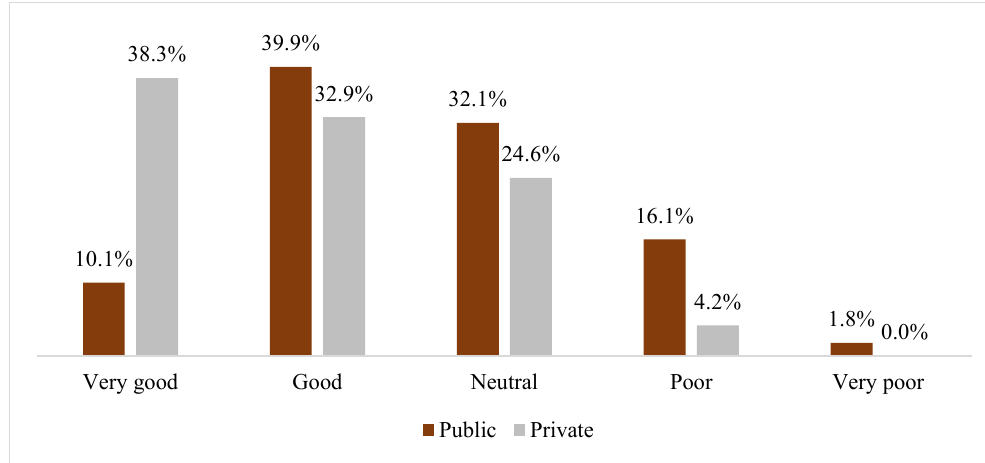
Fig. 4. Working conditions. Source: The authors’